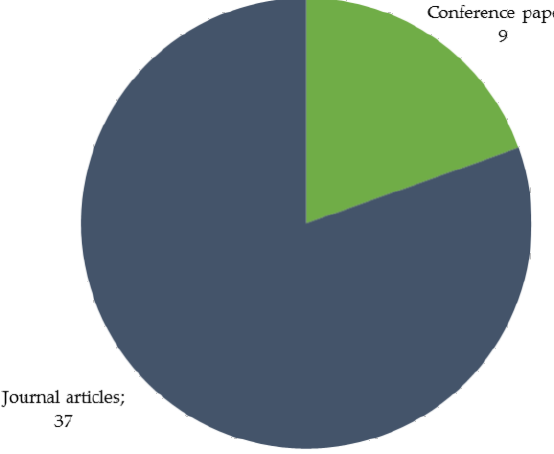
Figure 6. Graph of document type.